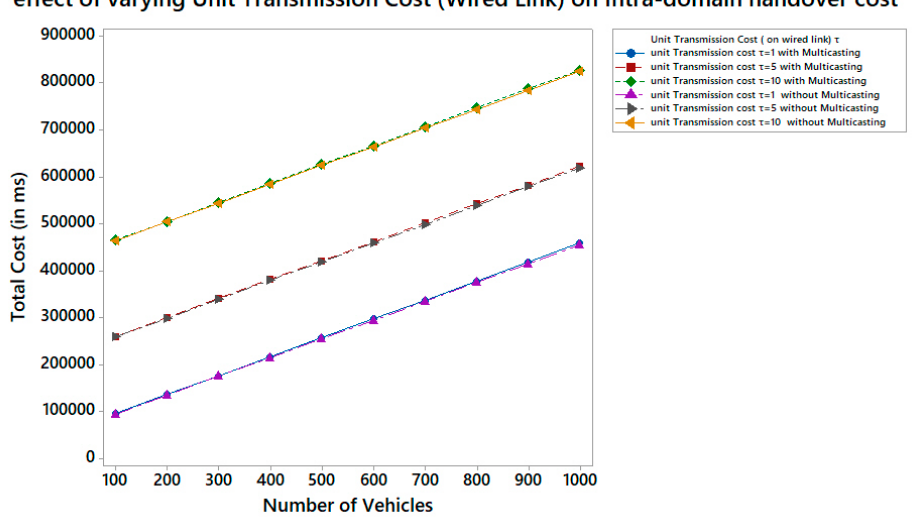
Figure 7. Effect of varying unit transmission cost (wired link) on intra-domain handoff .